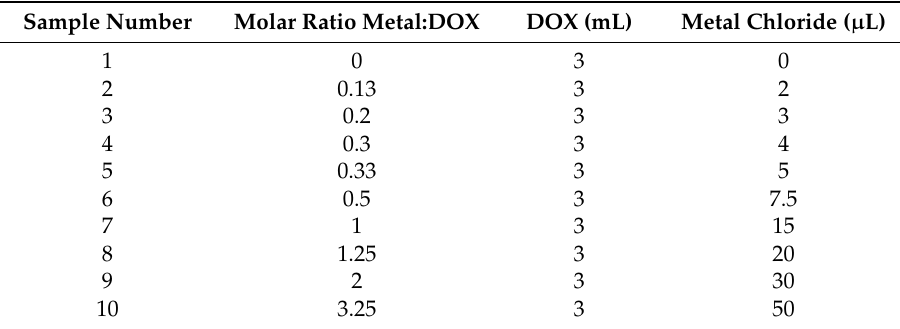
Table 3. Quantities of DOX and metal